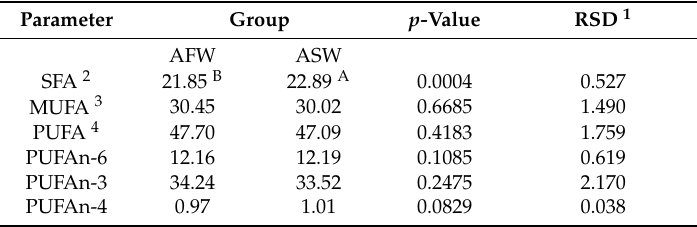
Table 4. Groups of fatty acids (in % of total fatty acids) of the fillet in European sea bass reared in AFW and ASW.